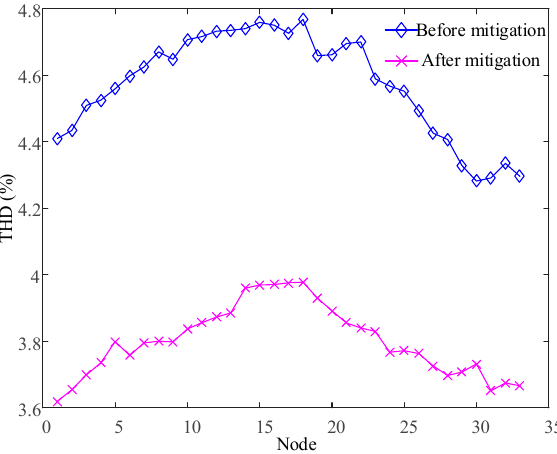
Figure 9. THD of each node at 16:00.